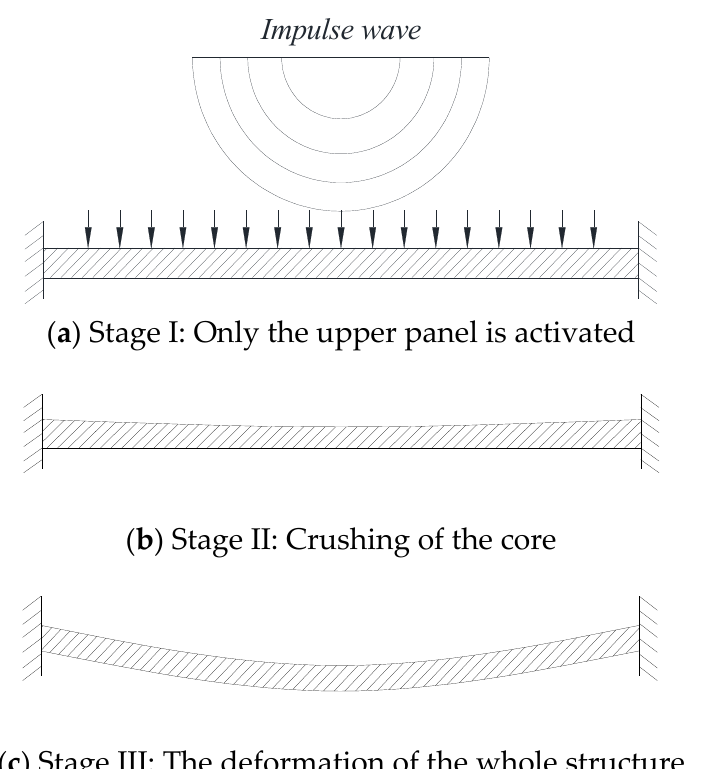
Figure 2. Dynamic response process of the metal sandwich structure under an impulse wave.